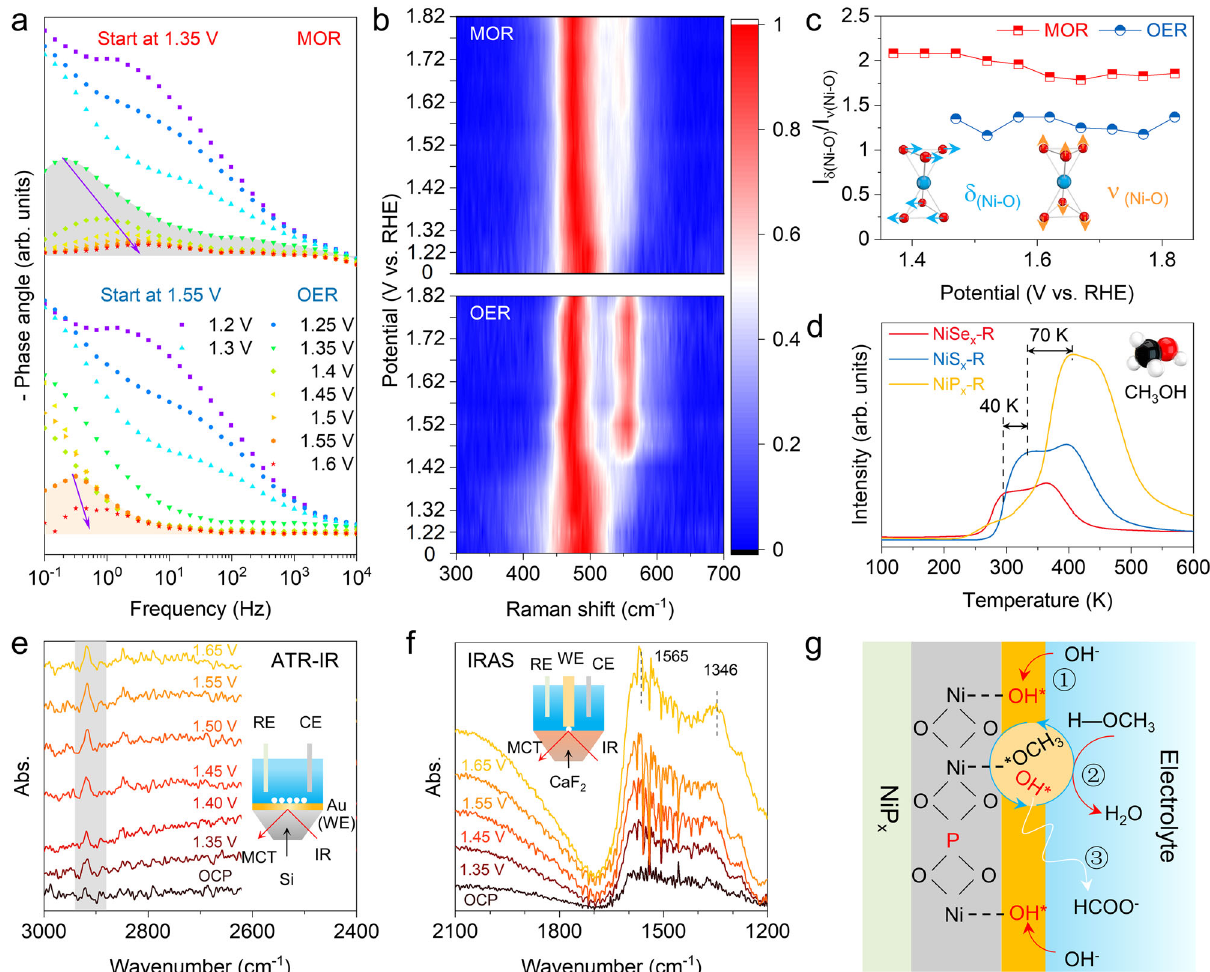
Fig. 5 MOR mechanism analysis of NiP x -R by in situ and ex situ experiments. a Bode plots of NiP x -R for OER and MOR in different potentials. b In situ Raman spectroscopy of NiP x -R for OER (1 M KOH) and MOR (1 M KOH with 0.5 M methanol). c The δ (Ni-O) -to- ν (Ni-O) ratios in the electrochemical in situ Raman spectra are related to the operating potentials. d Temperature-programmed desorption (TPD) curves of NiP x -R, NiS x -R, and NiSe x -R for methanol molecule. e ATR-IR spectra taken on the NiP x -R surface in the electrolyte of 0.1 M KOH with 0.5 M methanol in different potentials. f IRAS spectra of MOR on the NiP x -R surface in the electrolyte of 0.1 M KOH with 0.5 M methanol in different potentials. g Schematic illustration of the MOR mechanism on the NiP x -R